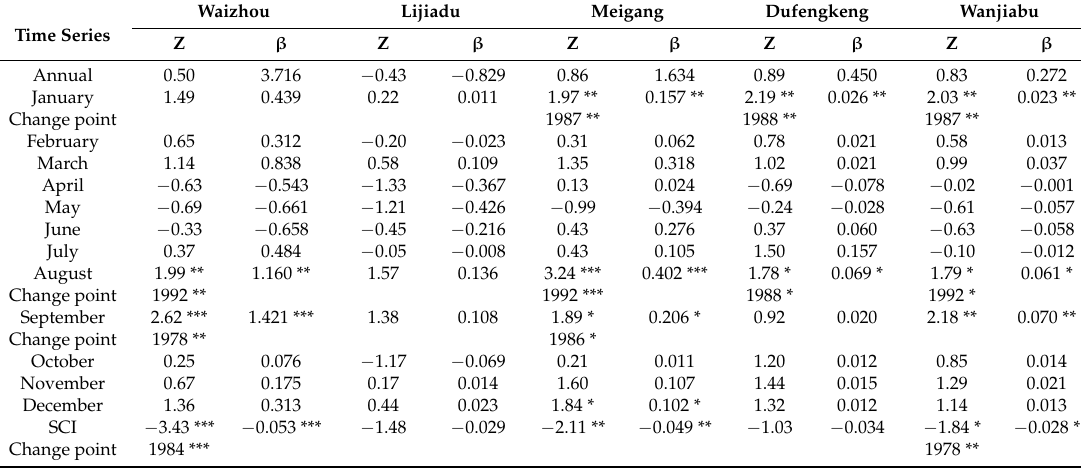
Table 3. Results of MK test, Theil–Sen approach and Pettitt test for stream flow time series in the Poyang Lake Basin from 1961 to